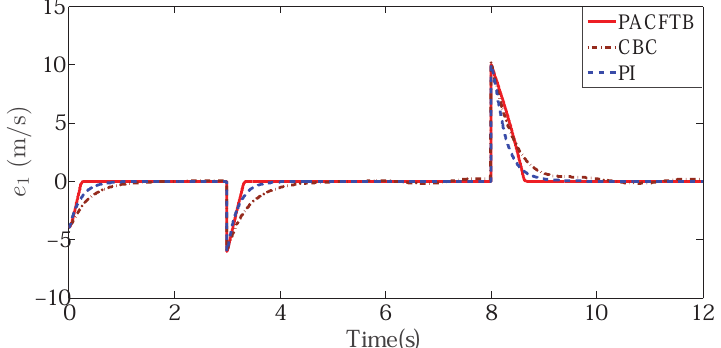
Figure 5. LIM speed tracking error with different controller.